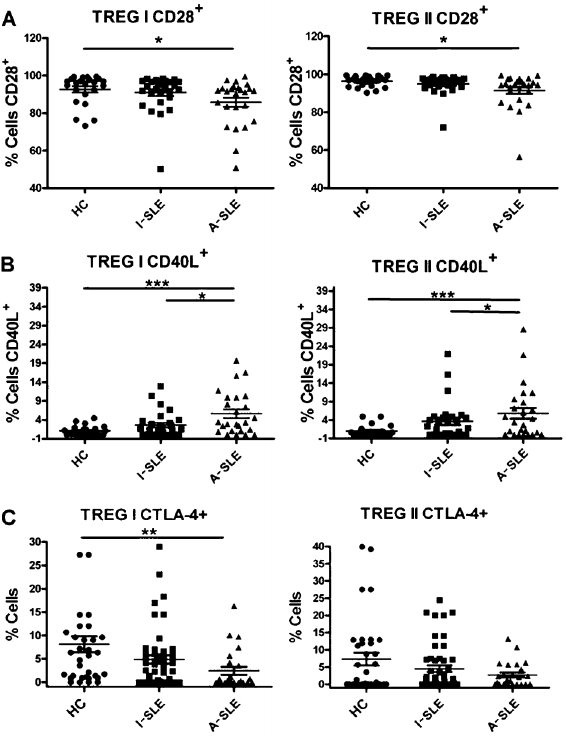
Figure 3. Analysis of the frequency of TREG-I (CD25 + CD127 Ø/low FoxP3 + ) and TREG-II (CD25 high CD127 Ø/low FoxP3 + ) cells expressing CD28 ( A ), CD40L ( B ), and CTLA-4 ( C ) in patients with active SLE (A-SLE), inactive SLE (I-SLE), and healthy controls (HC). The relative frequency of CD28 + , CD40L + , and CTLA-4 + cells was calculated over total TREG-I and TREG-II, respectively. Horizontal bars indicate means and standard deviation, respectively. *P , 0.05; **P , 0.01; ***P , 0.001 (Kruskal-Wallis test).